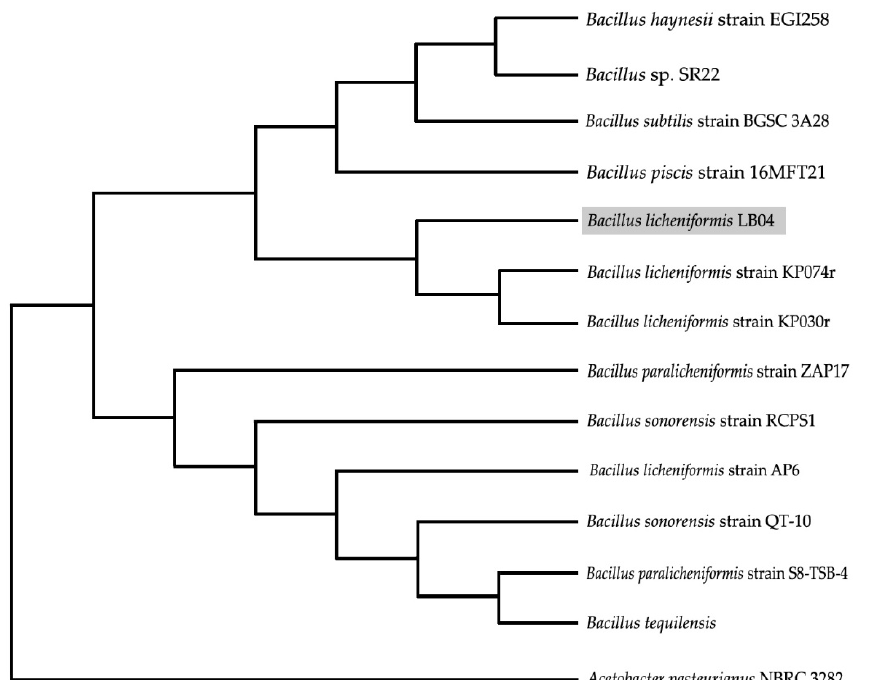
Figure 1. Molecular identification based on 16S rDNA sequence. The phylogenetic tree was con- structed by a neighbor-joining algorithm based on the 16S rDNA gene sequences of B. licheniformis strain LB04 against related species of Bacillus .